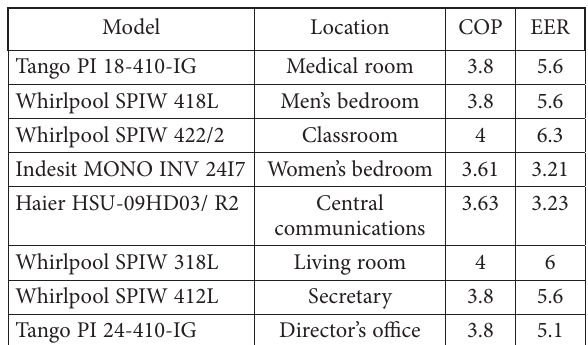
Table 4. COP and EER for different air conditioner models and